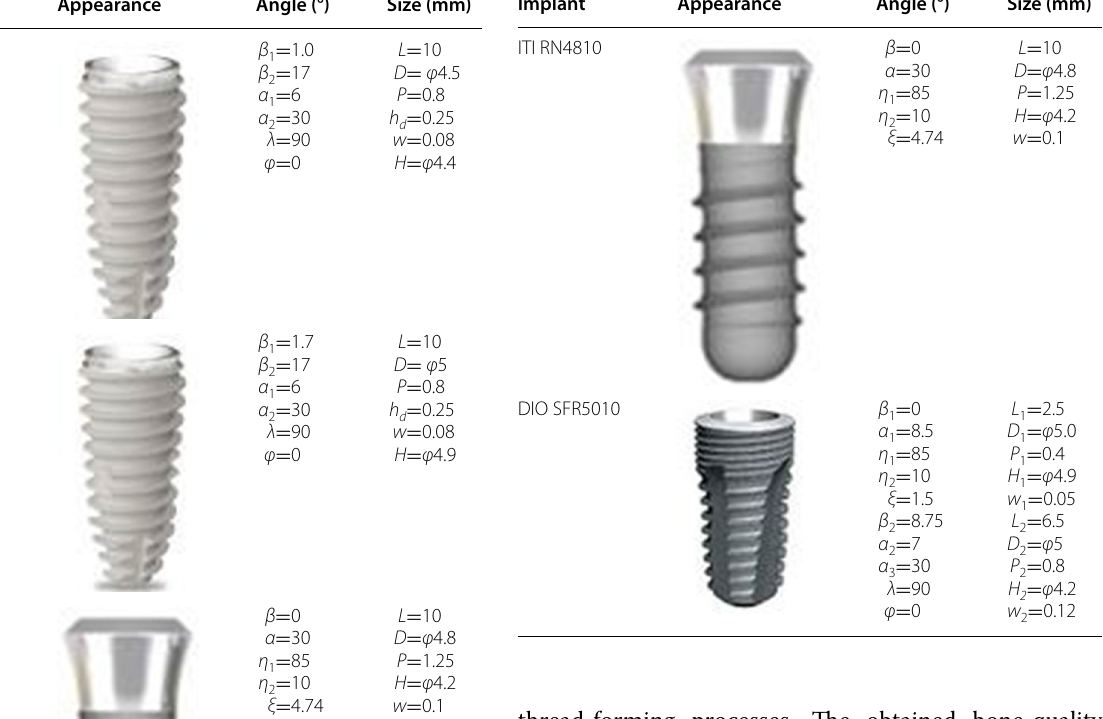
Table 2 Implant parameters